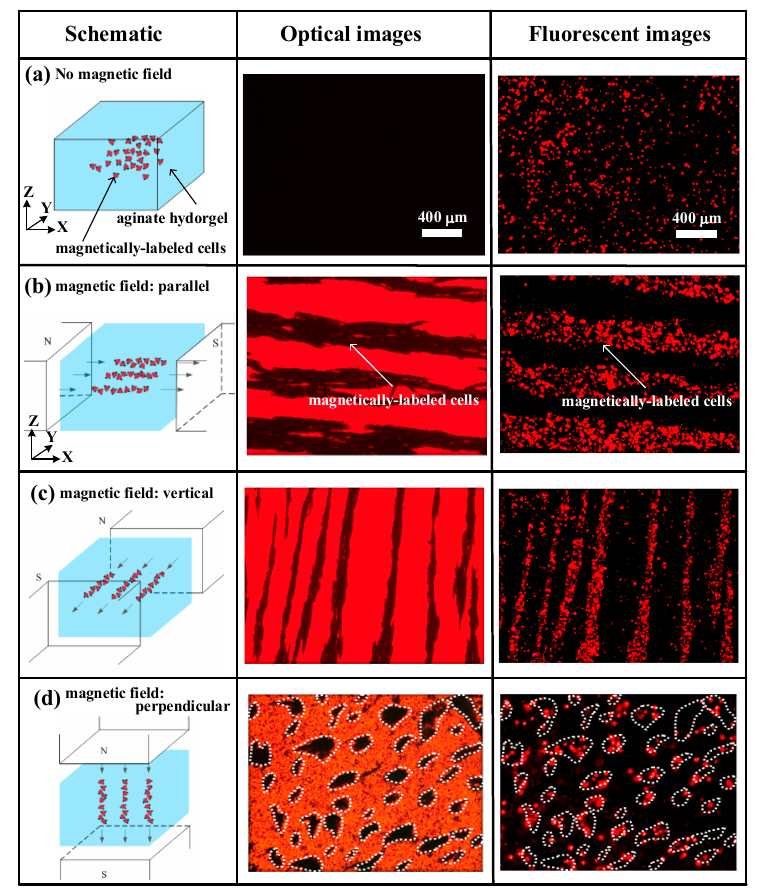
Figure 5. The optical and fluorescent images of magnetically-guided cells encapsulated in rectangular alginate hydrogels after performing light-addressable electrodeposition, where the magnetically-labeled cells were randomly distributed with no applied magnetic field in ( a ) or manipulated into ( b ) parallel, ( c ) vertical, and ( d ) perpendicular alignments by rotating a pair of NdFeB magnets horizontally (in X – Y plane) or perpendicularly (in X – Z plane). The undoped a-Si:H ITO glass substrate showed red color in optical images; DiI-labeled BHK-21 cells showed red fluorescence in fluorescent